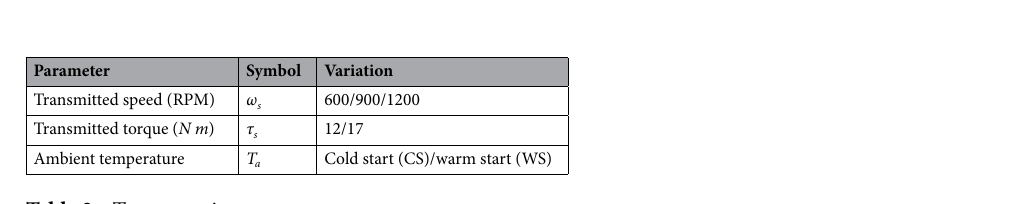
Table 2. Test operating